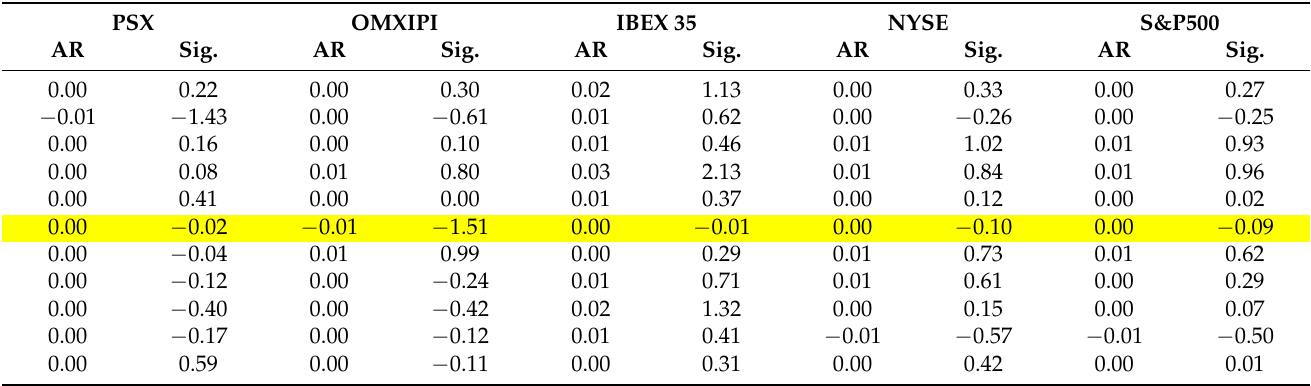
Table A33. Abnormal returns of the ( − 5, +5) event window (Resignation of D. Jos é Manuel Soria, Spain’s Minister of Industry).